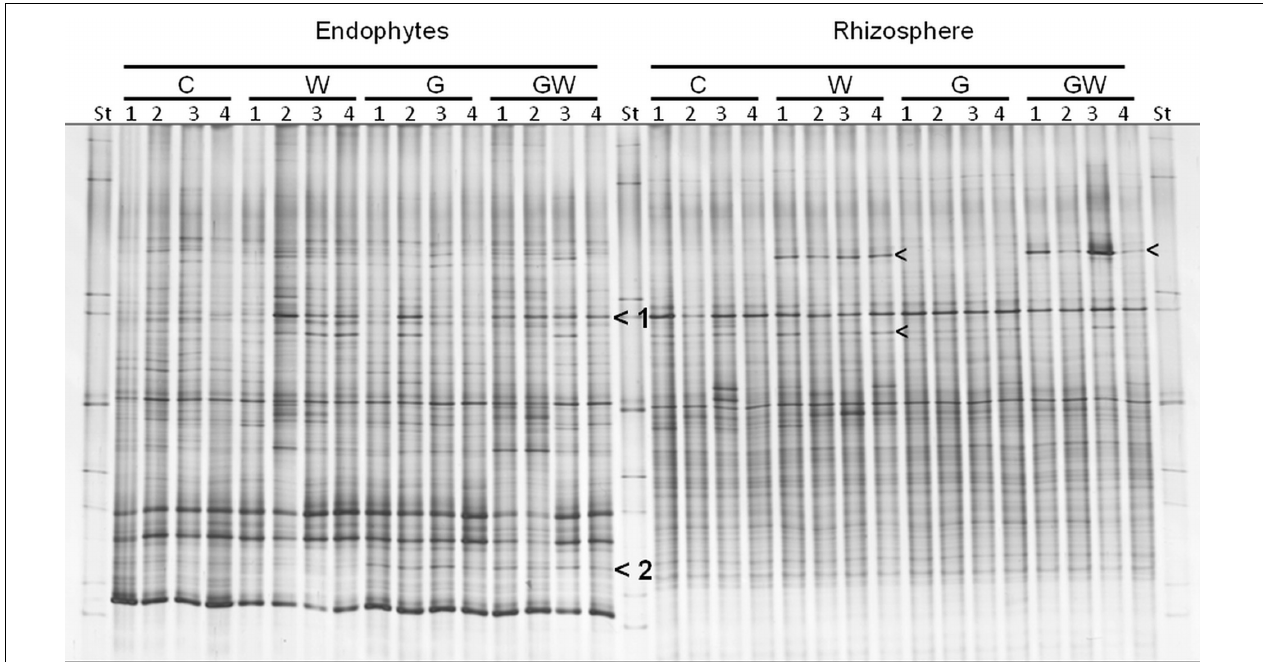
FIGURE 4 | DGGE fingerprints of 16S rRNA gene fragments showing the endorhiza and rhizosphere bacterial communities of maize plants from the treatments C, W, G, and GW. C, maize plant grown in Haplic Chernozem, natural source of different mycorrhizal species; W, maize plants characterized by 3 weeks root feeding by WCR larvae; G, maize plants with GI inoculum